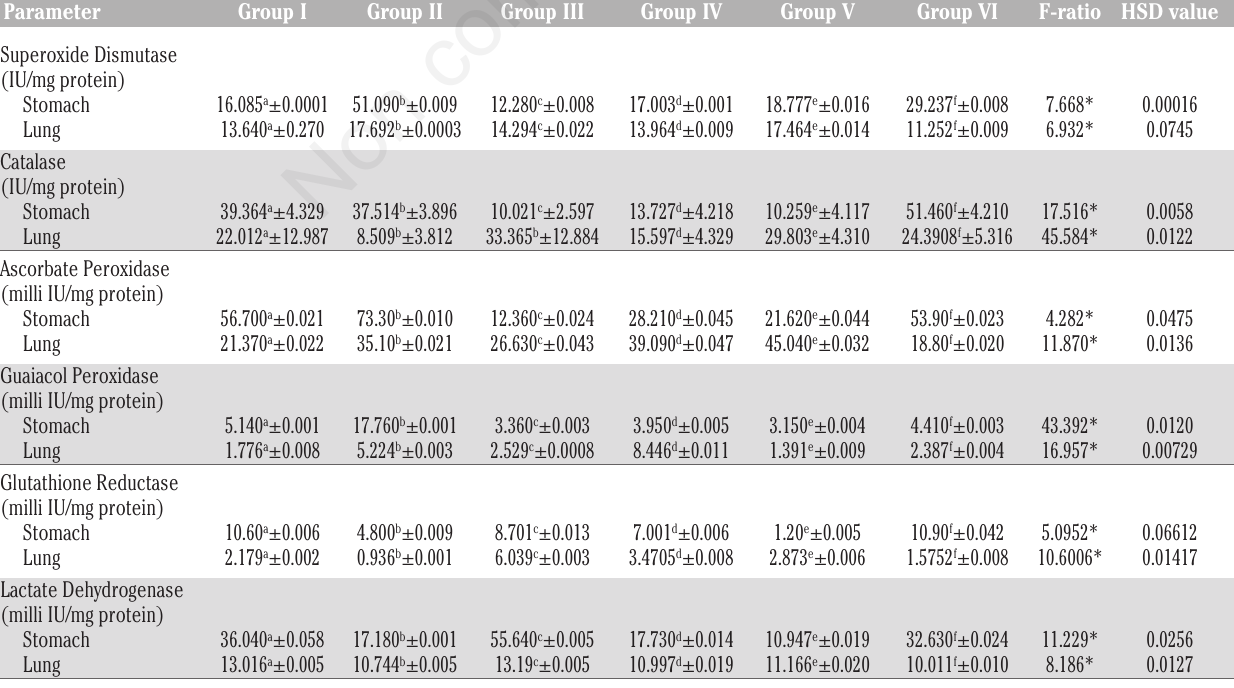
Table 4. Modulation of DMBA induced impairment of antioxidant enzymes by betulinic acid among different treatment groups of female Sprague Dawley rats.